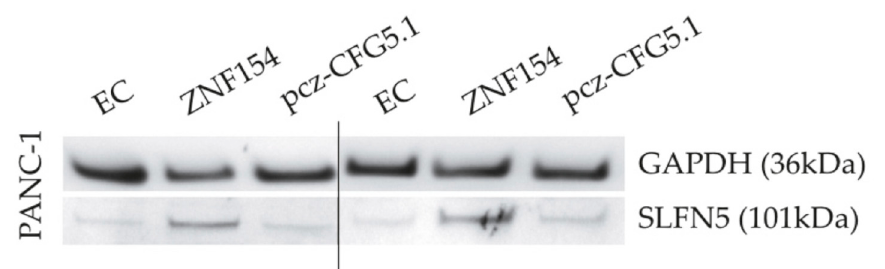
Figure 5. Western blots of PANC-1 cells transiently transfected with empty control (EC), ZNF154, or pcz-CFG5.1 (positive control).